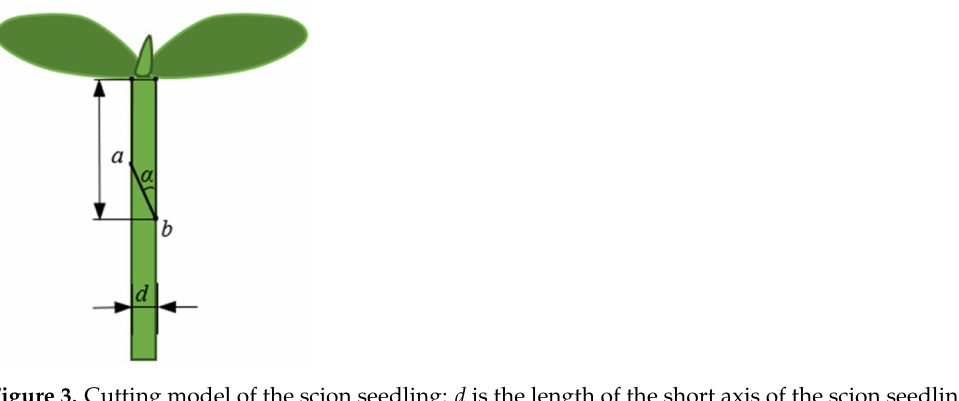
Figure 3. Cutting model of the scion seedling: d is the length of the short axis of the scion seedling (mm), l ab is the length of cutting surface of the scion (mm), α is the cutting angle of the scion ( ◦ ), and h is the hypocotyledonary axis length after cutting the scion